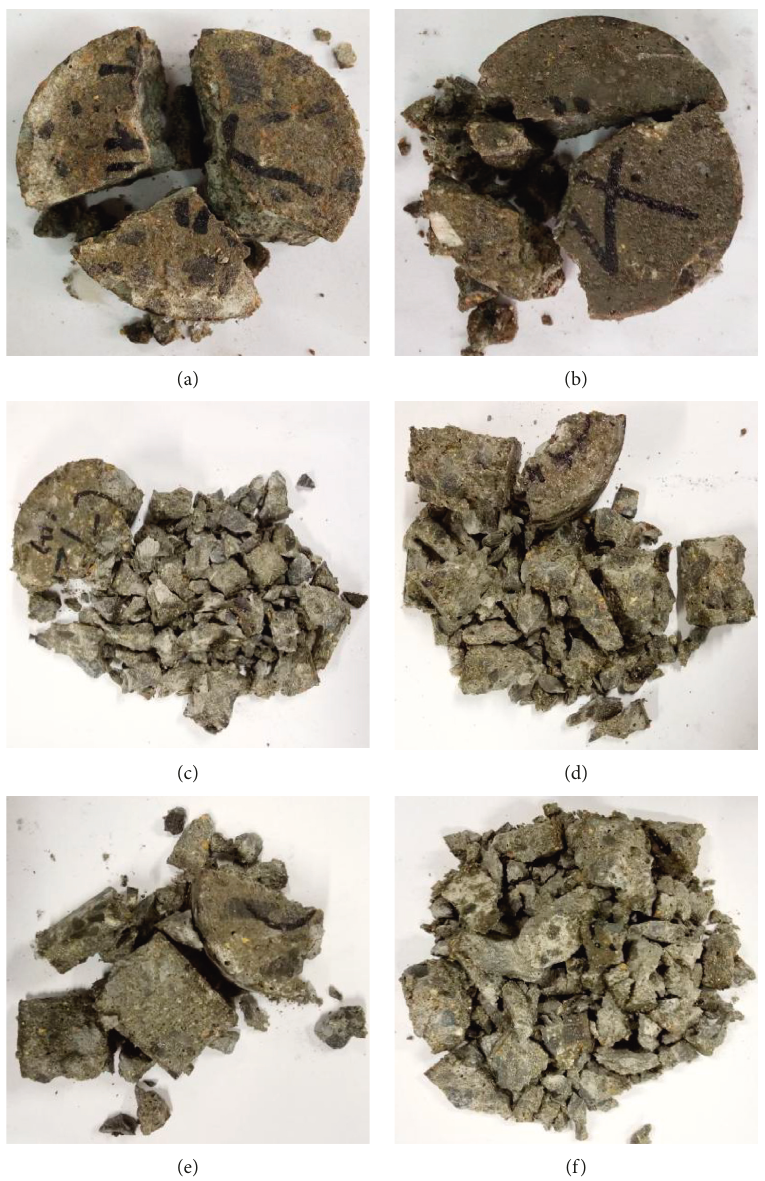
Figure 13: Failure mode of ready-mixed concrete in uniaxial load state. (a) WC0-SP0. (b) WC2.0-SP3. (c) WC2.0-SP7. (d) WC2.0-SP15. (e) WC2.0-SP20. (f)